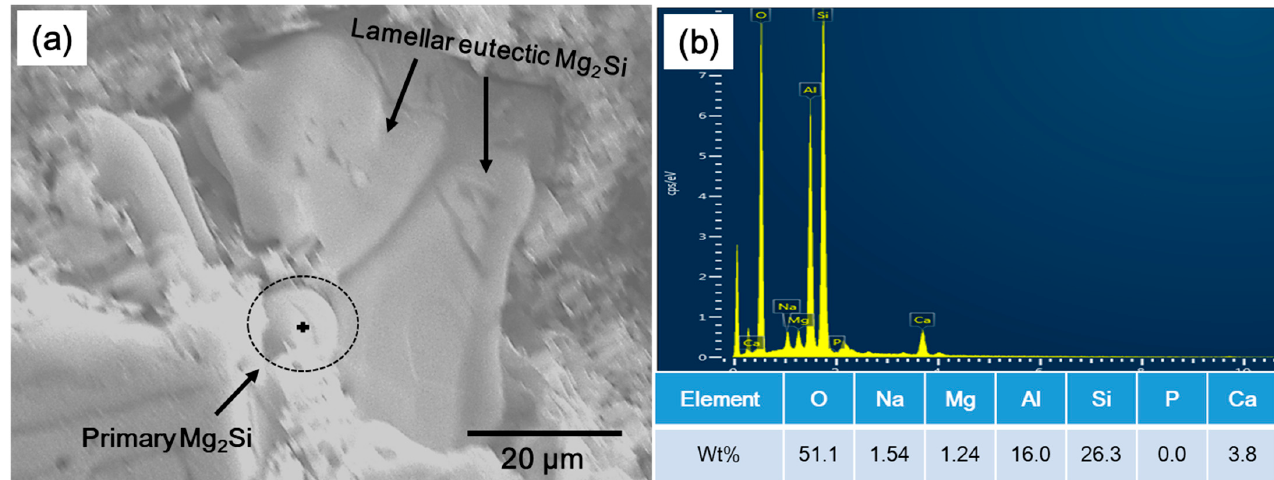
Figure 6. ( a ) SEM microstructure of deep-etched A1 alloy showing a coarse binary eutectic Al–Mg2Si phase and a primary Mg2Si phase in the middle of it. ( b ) It showed the EDS-analysis result of a point, indicated with a plus sign in ( a ), located on this central primary Mg2Si phase, which has shown the presence of Ca element in it.